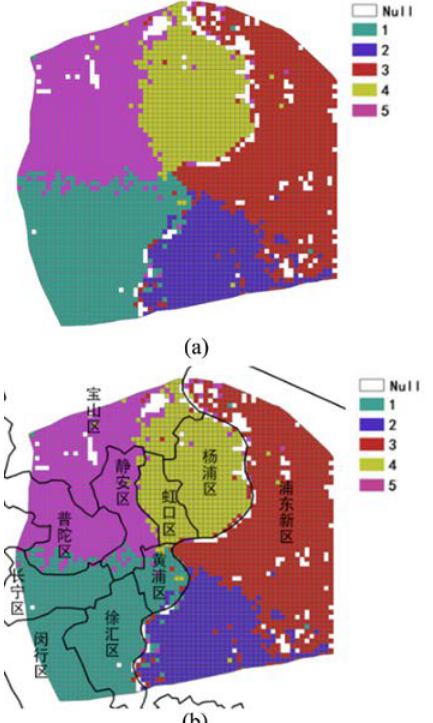
Figure 7. The detection result of urban structure in the studied area: (a) the visualization by ARCGIS; (b) the detection result compared with the administrative map: the regions are cohesive and have clear boundary which almost confirms to the boundary of administrative